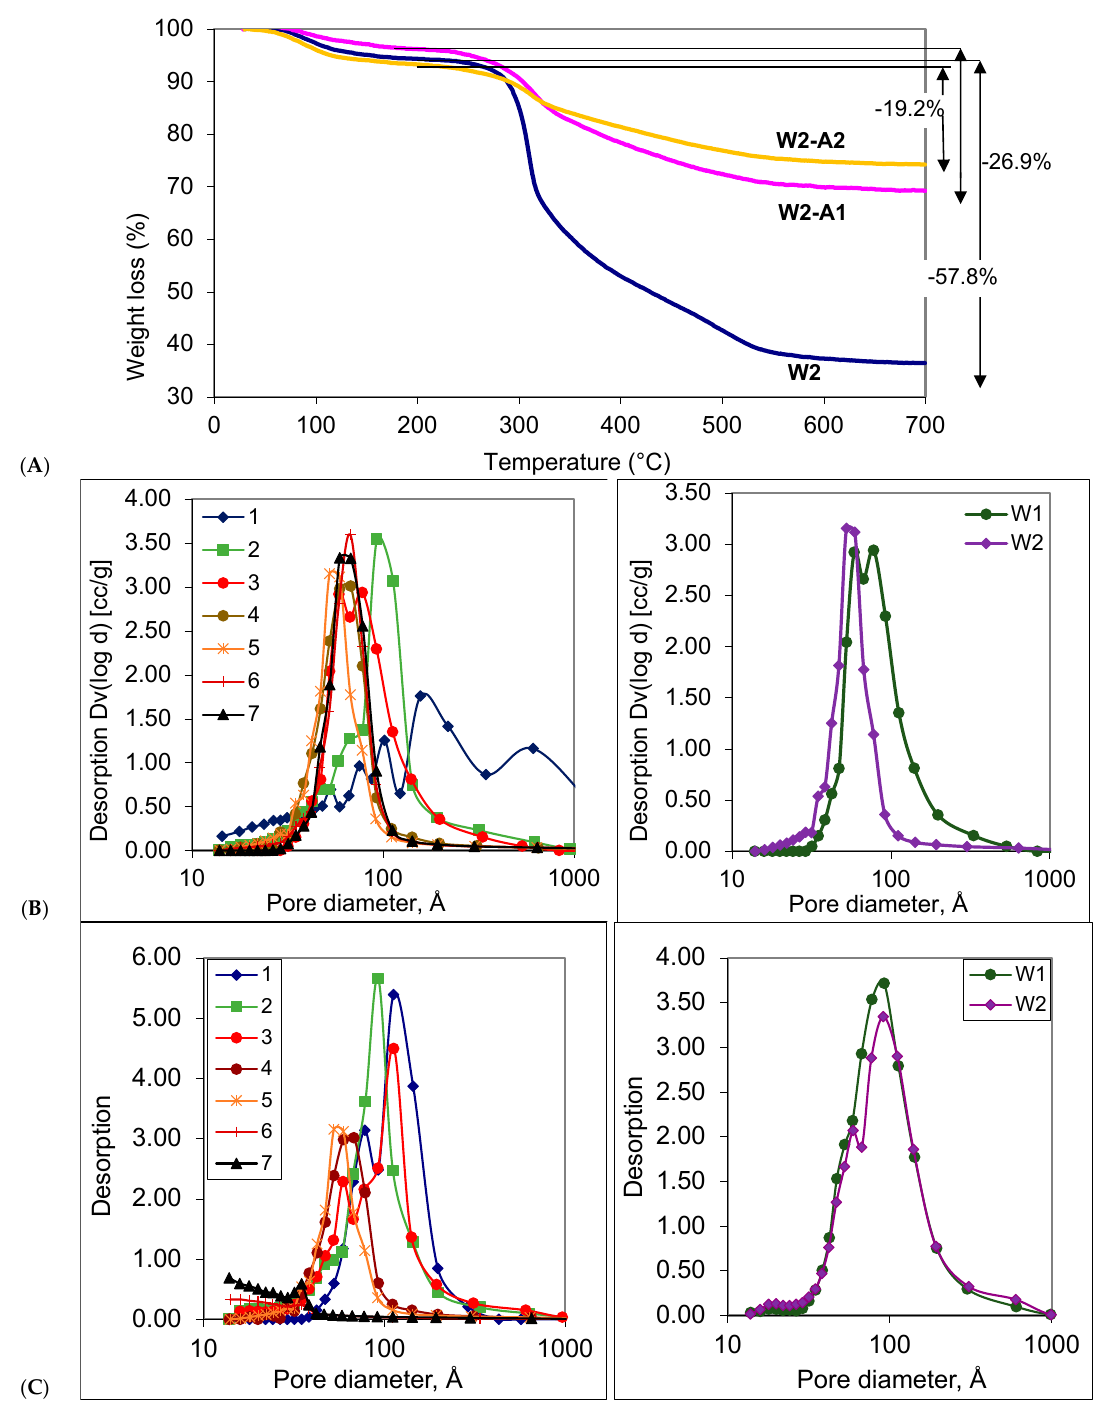
Figure 8. ( A ) TGA analyses of W2 , W2-A1 and W2-A2 . ( B ) Pore size distribution of the samples after ( B ) 1st enzyme digestion and ( C ) after calcination at 600 °C of typical samples (left) and worm- containing samples (right).